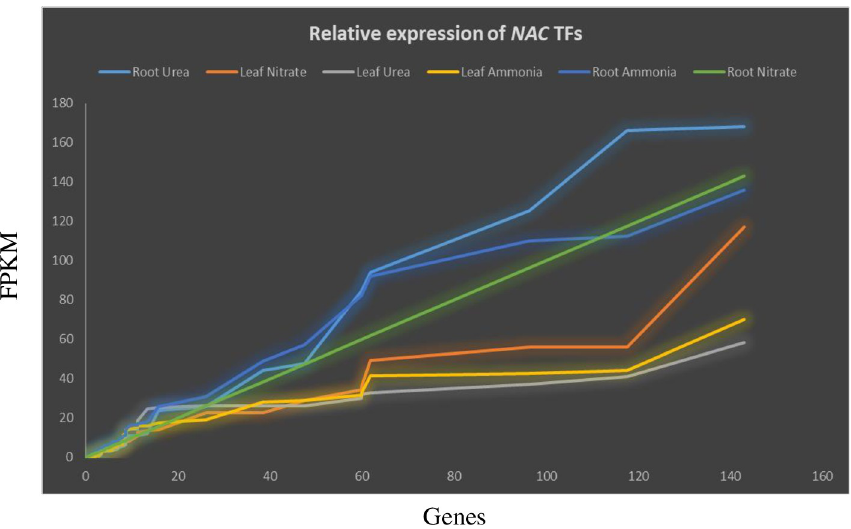
Fig 6. Differential expression of NAC TFs in leaves and roots of A . thaliana plants treated with ammonia, nitrate, and urea. The expression of A . thaliana NAC TFs was analysed to determine their response to different sources of nitrogen. Urea and ammonia in root tissue show higher expression level whereas urea treated leaf tissue showed low level of NAC expression. The expression data were obtained from the PhytoMine database in Phytozome and presented as FPKM (Fragments per Kilobase of transcripts per million mapped reads). The X-axis represents the NAC TF genes and Y-axis represent the Fragments per Kilobase of transcripts per million mapped